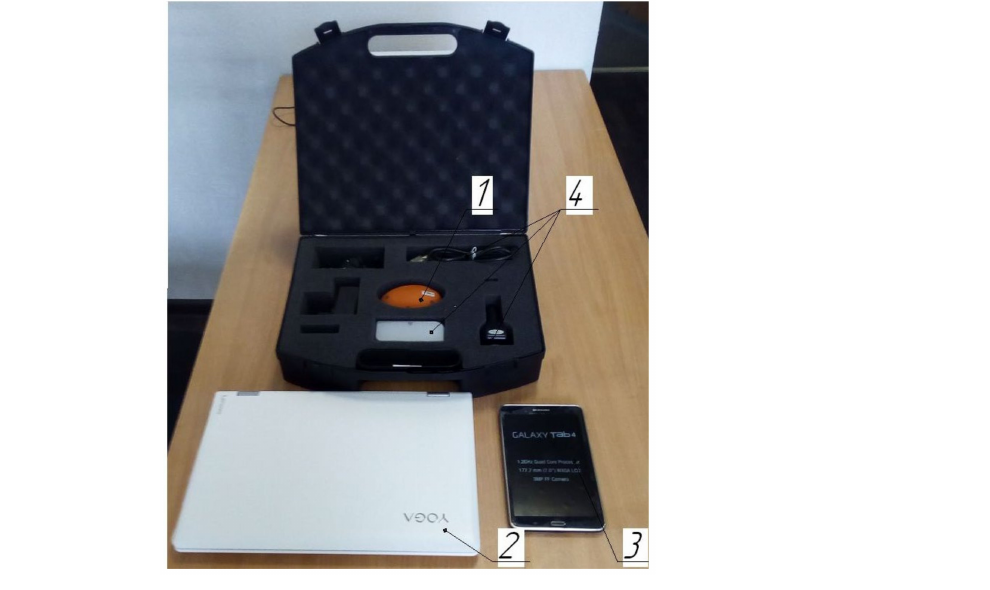
Figure 10. General view of Electronic Potato (Tuber Log) software tool: 1—data logger; 2—personal computer; 3—tablet computer; 4—auxiliary equipment.